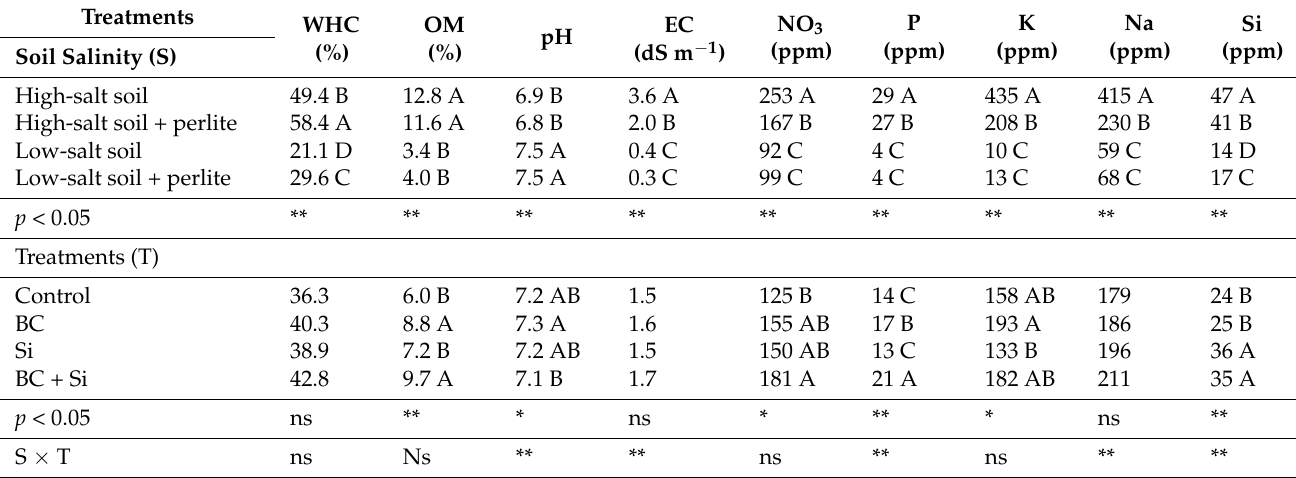
Table 1. Soil nutrient values and significance levels in Experiment